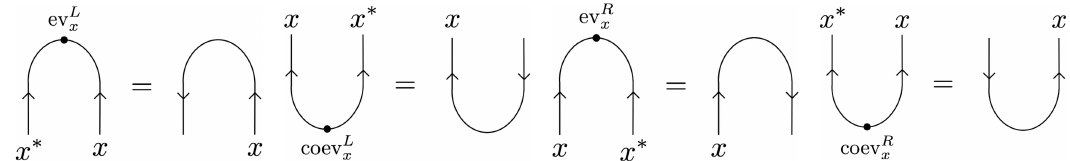
Figure 1 . The left and right (co)evaluation morphisms describe the operation of folding topological defect lines to the left and right respectively. In the folded diagrams, topological point operators corresponding to (co)evaluation morphisms are often